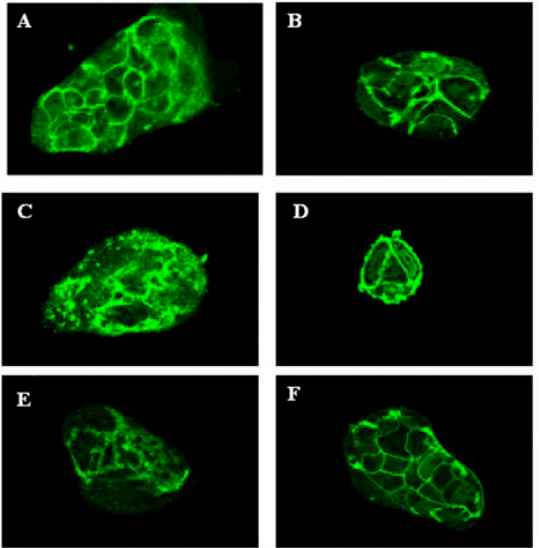
Figure 4. MBCP ameliorates the adherens junctions destructured by atropine and tubocurarine. Confocal microscopy images of untreated Caco-2 cells ( A ) or Caco-2 cells treated for six hours with MBCP (18 µ M, ( B )), tubocurarine (10 µ M, ( C )), Tubocurarine plus MBCP ( D ), atropine (10 µ M, ( E )) and atropine plus MBCP ( F ). The color green represents β -catenin.